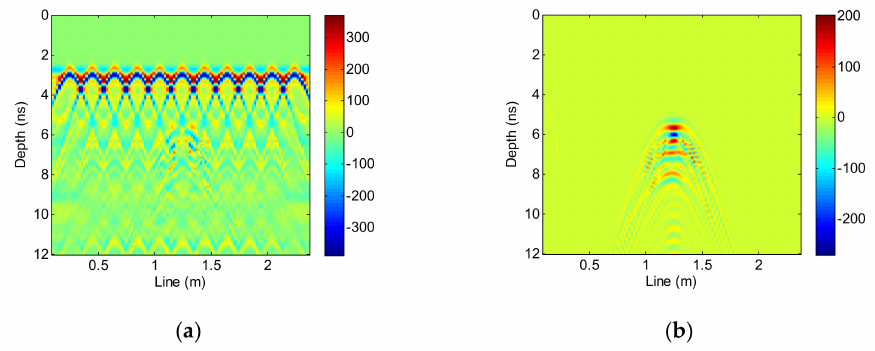
Figure 3. The paired simulation results of the diseases: ( a ) with rebar, and ( b ) without rebar.